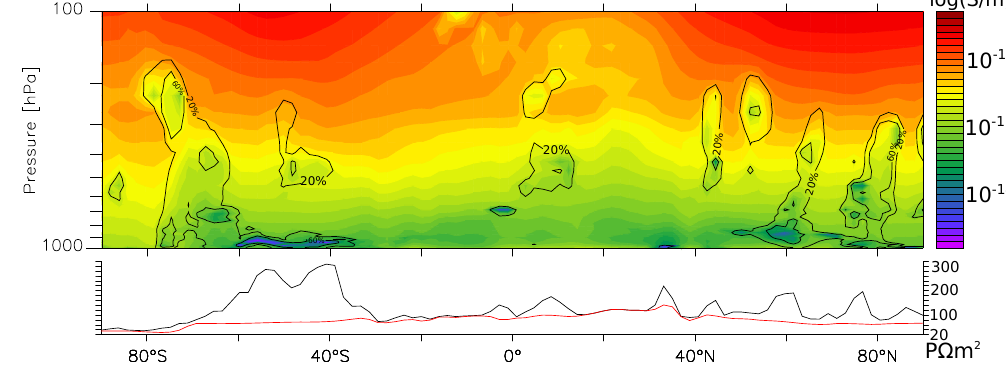
Figure 7. Top: logarithm of conductivity from CESM1(WACCM) for 30 ◦ E and 16 September 2005, 00:00UTC, using the cloud conductivity parameterization. The black contour lines indicate cloud cover fraction (20%, 60%, 100%). Bottom: column resistance for the same location, using the cloud parameterization (black) and neglecting clouds (red).